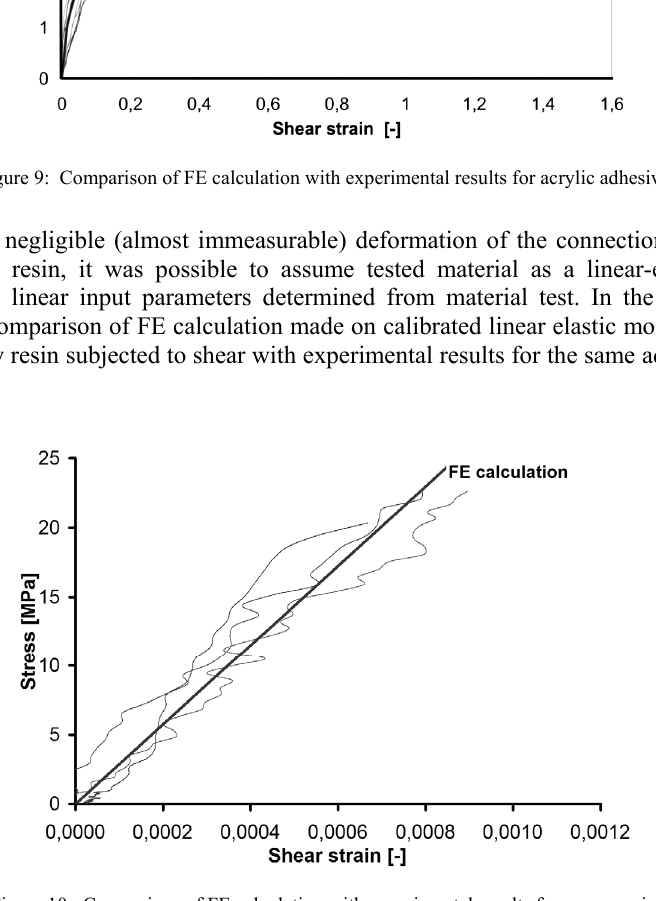
Figure 10: Comparison of FE calculation with experimental results for epoxy